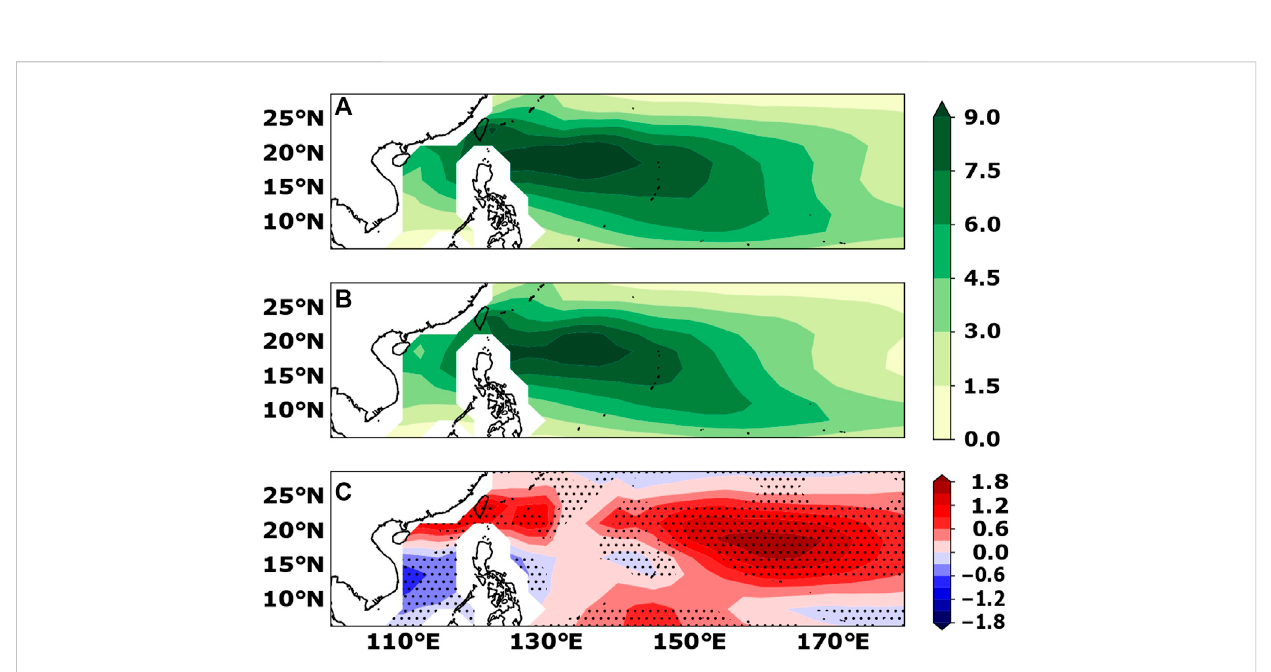
FIGURE 8 SpatialmapofJJAStime-meantropicalcyclogenesispotentialindex(GPI)fortheperiod1951 – 2005: (A) HIST, (B) HISTNATand (C) (HIST – HISTNAT). The dots indicate statistical signi fi cance ( p < 0.05) based on Student ’ s